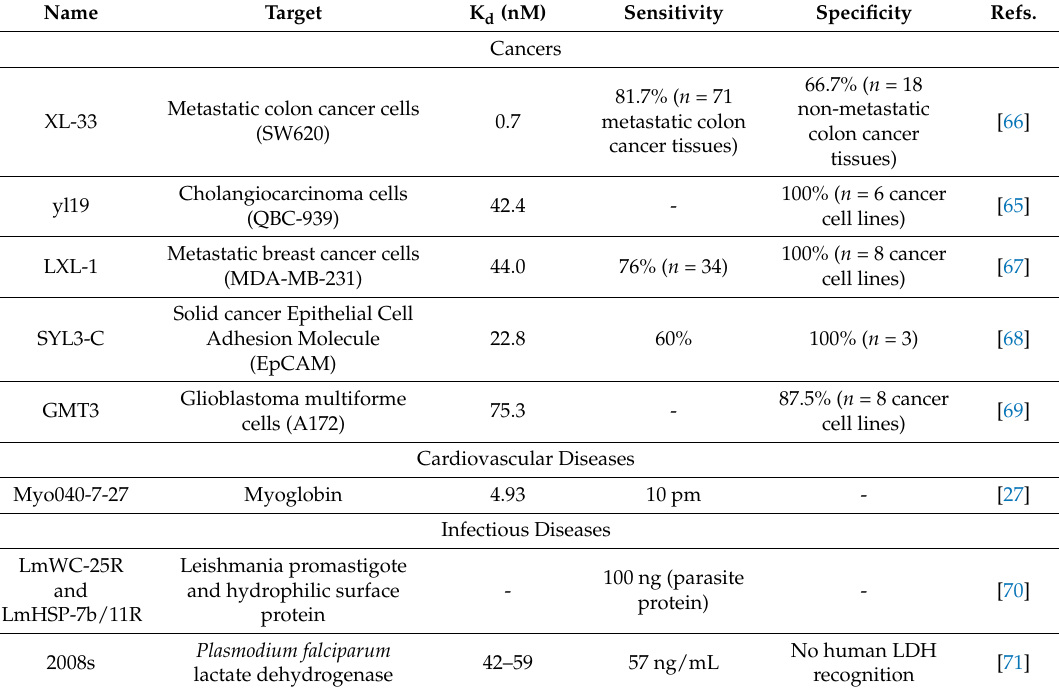
Table 3. Examples of recently developed aptamers for the diagnosis of human